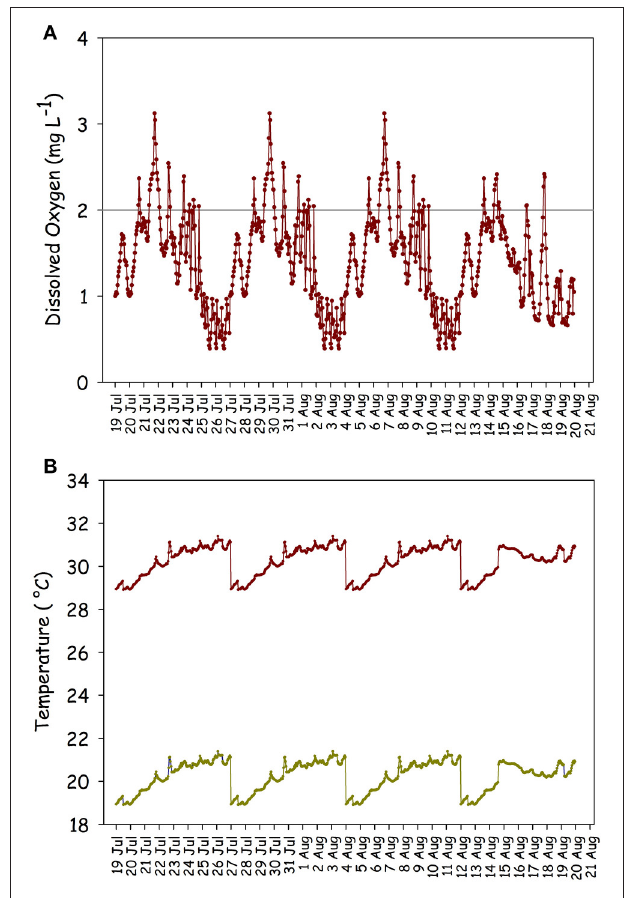
FIGURE 3 | (A) DO series comprising 768 hourly values over 32 d; (B) corresponding alternate warm and cool temperature series which when combined with the DO series, create the two dynamic severe hypoxia exposure scenarios.